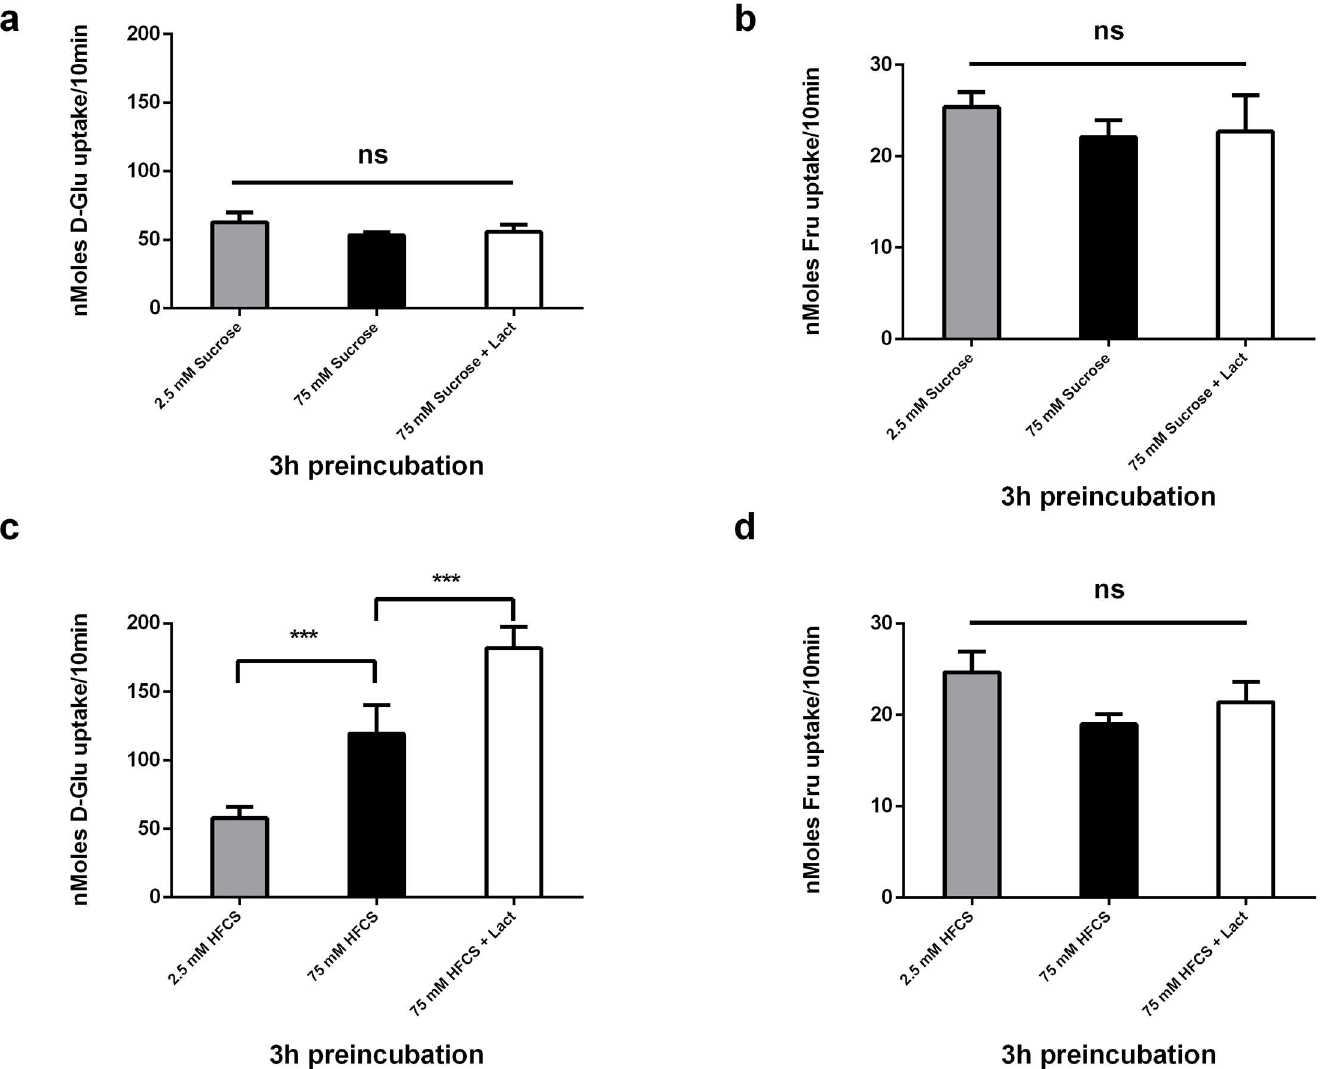
Fig 6. Acute effectsof Sucrose, an equimolar mix of free glucose and fructose, and lactisole on carriermediated [ 14 C] 10 mM D-Glucose and D-Fructose uptake into Caco-2/TC7 cells. Caco-2/TC7 cells grown for 21 days were incubatedwith 2.5 and 75 mM Sucrose or a 50/50 mix of free D- Glucose/D-Fructose in the presence or absenceof 0.5 mM lactisolefor 3hrs, washedin sugar free KBS. (a) and (c) are cellularuptake of [ 14 C] 10 mM D-Glucosefor 10 mins (b) and (d) are cellularuptake of [ 14 C] 10 mM D-Fructose measuredby radioactive scintillation spectrometry. Osmolarity was adjustedby addingMannitol.Uptake is corrected for simple diffusionof 10 mM [ 14 C] L-Glucose. Data are expressedas nMoles sugar uptake/well/ 10min ± SD of n = 4 per condition. * P < 0.05, ** P < 0.01, *** P < 0.001, ns = not